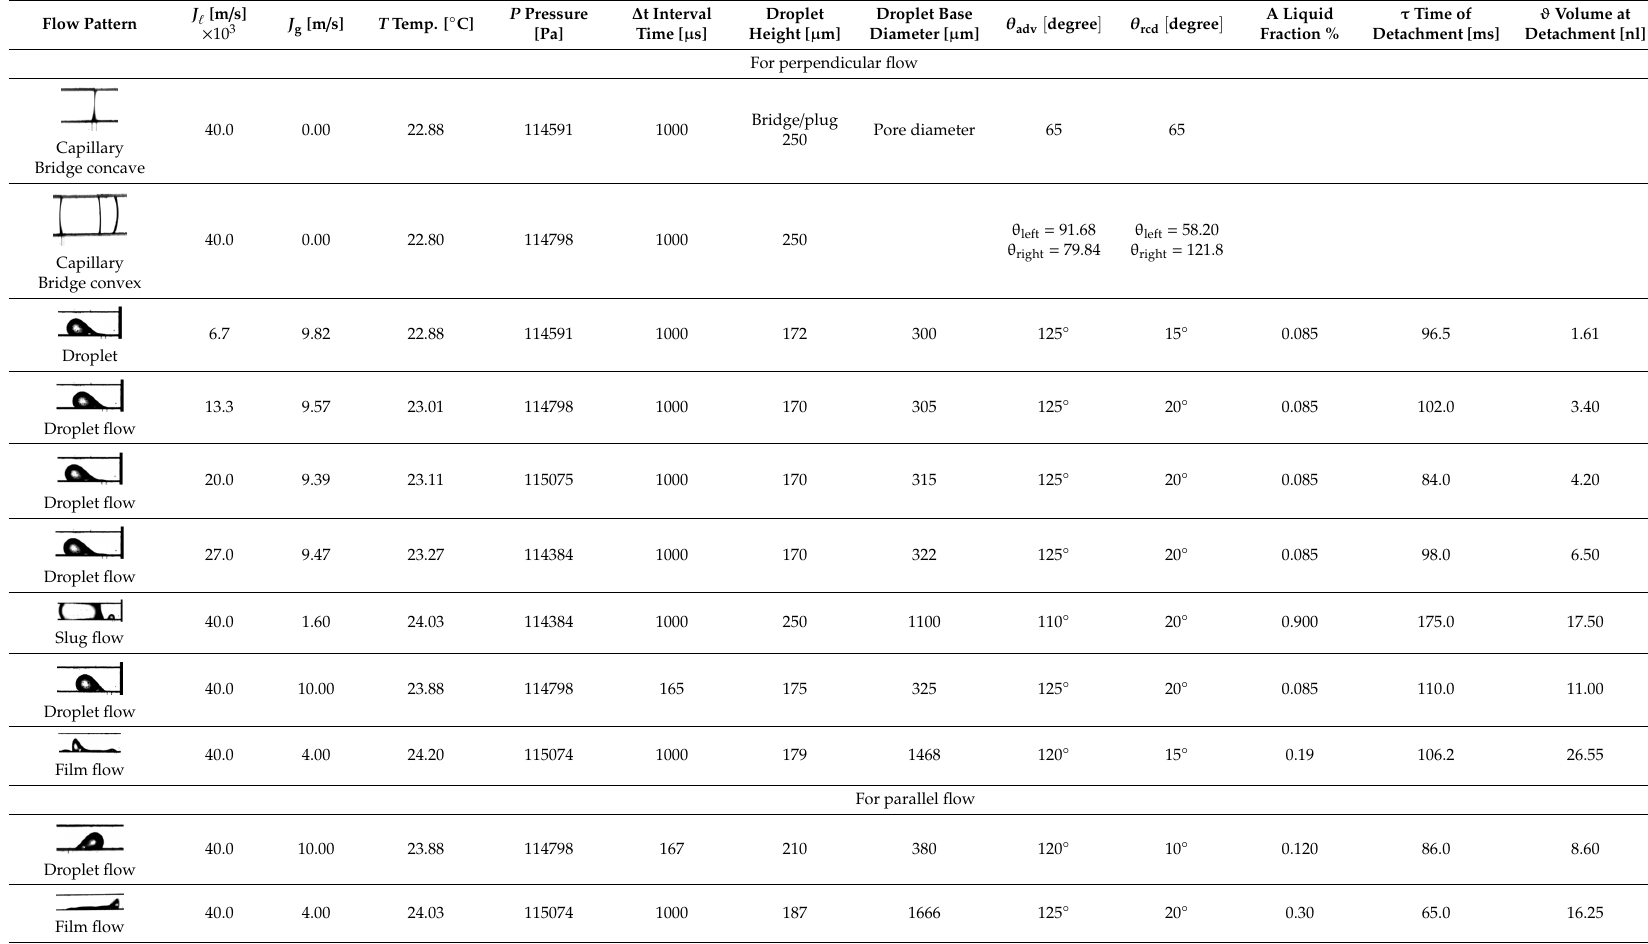
Table A1. Summary of the various parameters obtained by the image processing program.